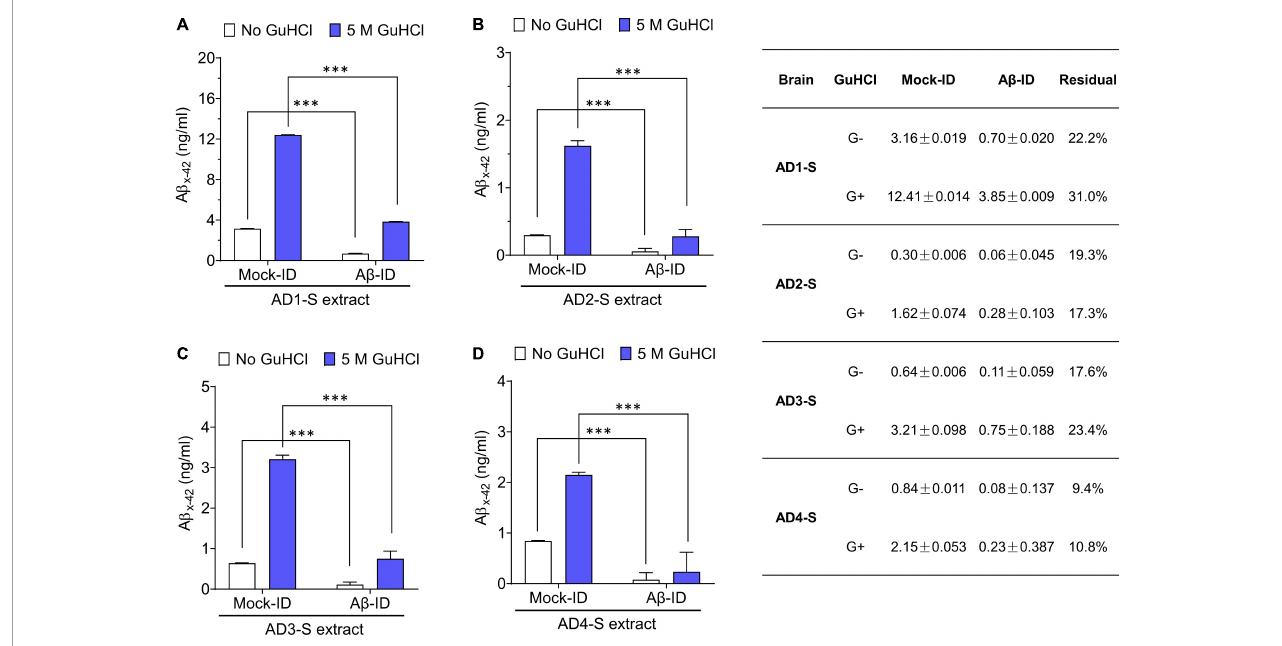
FIGURE3 Pan anti-A β polyclonal antibody S97 readily depletes A β from human brain extracts. (A–D) Samples were immunodepleted with S97 (A β -ID) or PIS (Mock-ID) conjugated to Protein A Sepharose beads (PAS). A β content in Mock-ID and A β -ID of S extracts from four AD brains was measured using the A β x-42 immunoassay ± pre-treatment with 5 M GuHCl. S97 effectively immunodepleted A β x-42 from S extracts of four AD brains. Table in the right panel indicates the values measured by ELISA. G– and G+ denote no GuHCl and 5 M GuHCl, respectively. Residual A β is presented as the ratio of A β